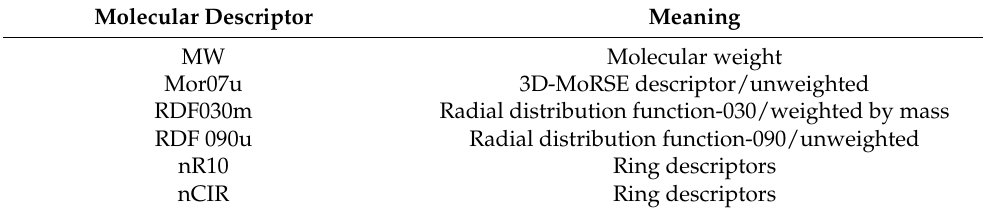
Table 2. Selected